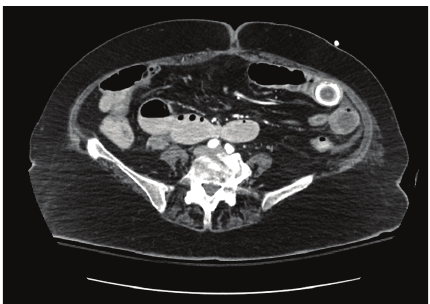
Figure 1: Abdomen and pelvis CT revealing intraluminal gallstone in the left lower quadrant leading to high grade bowel obstruction.